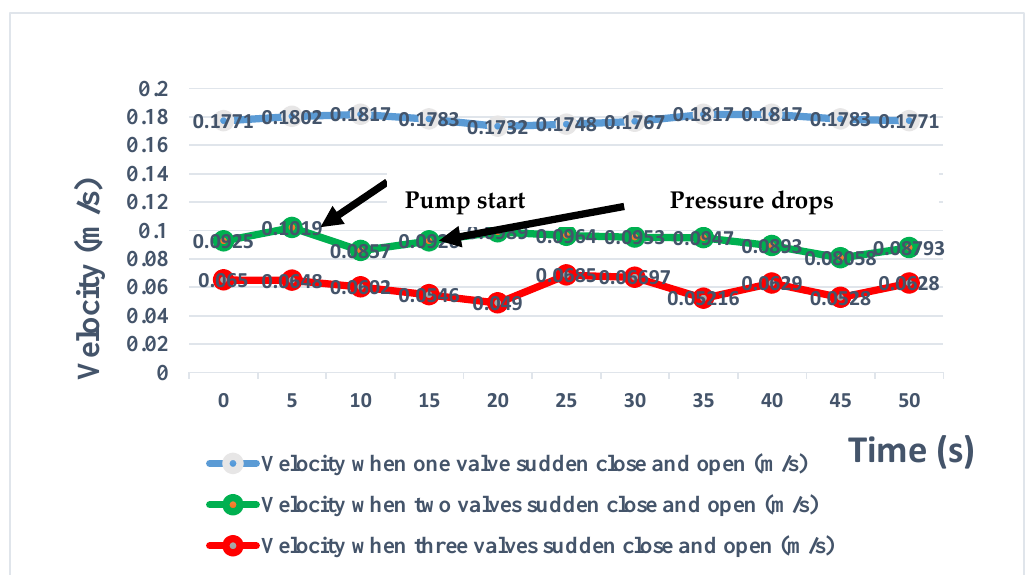
Figure 7. The velocity of pump processes behind the pump of a complete-time series in different positions of the valve.